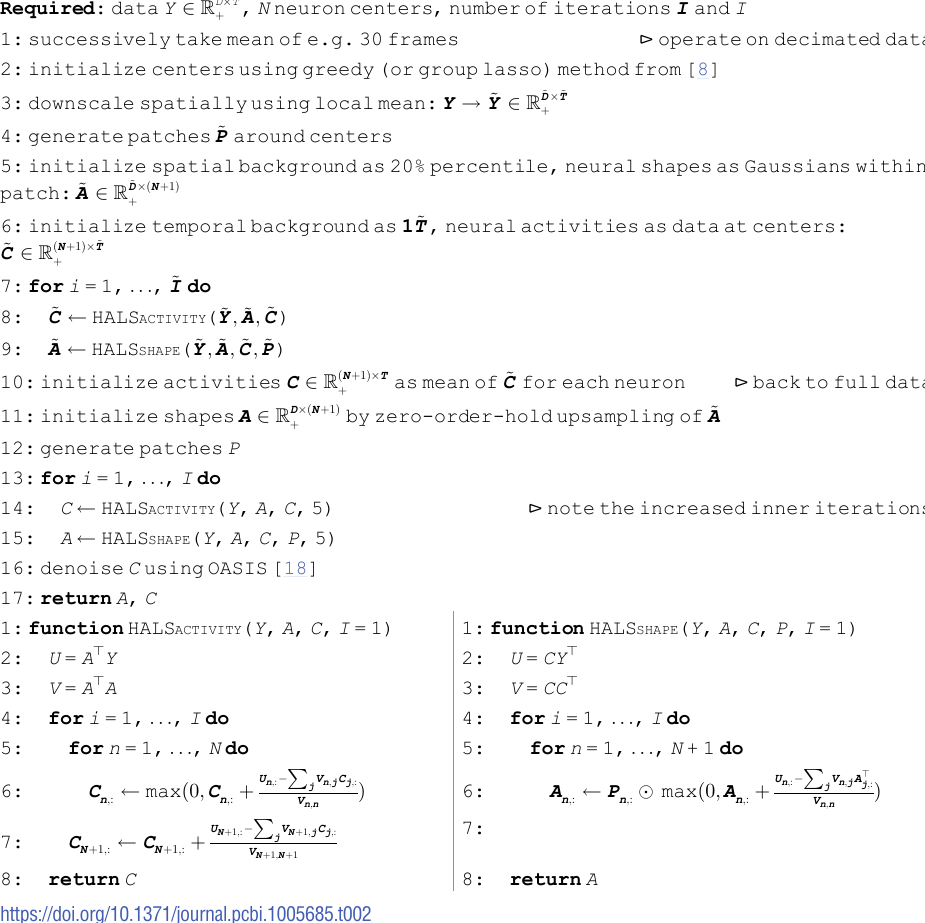
Algorithm 1. NMF algorithm using localization constraints and spatio-temporal